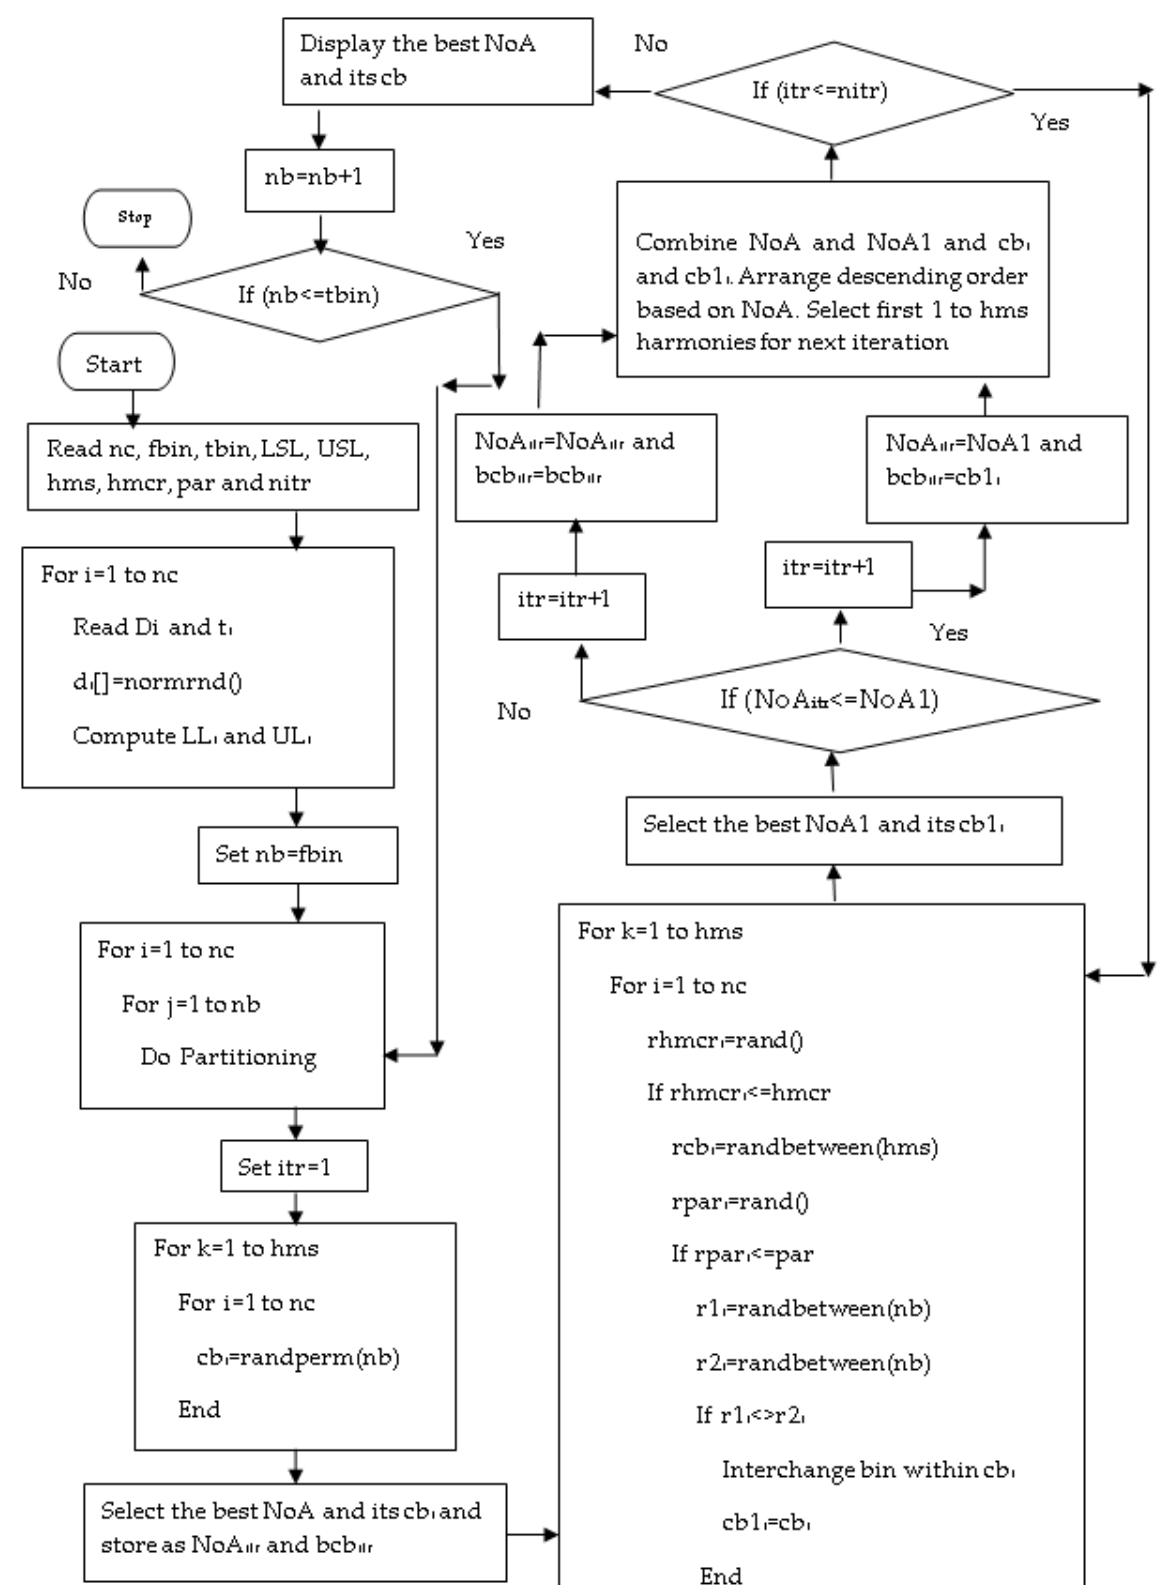
Figure 3. Implementation of HSA. Table 5. Technical terms and their meanings.